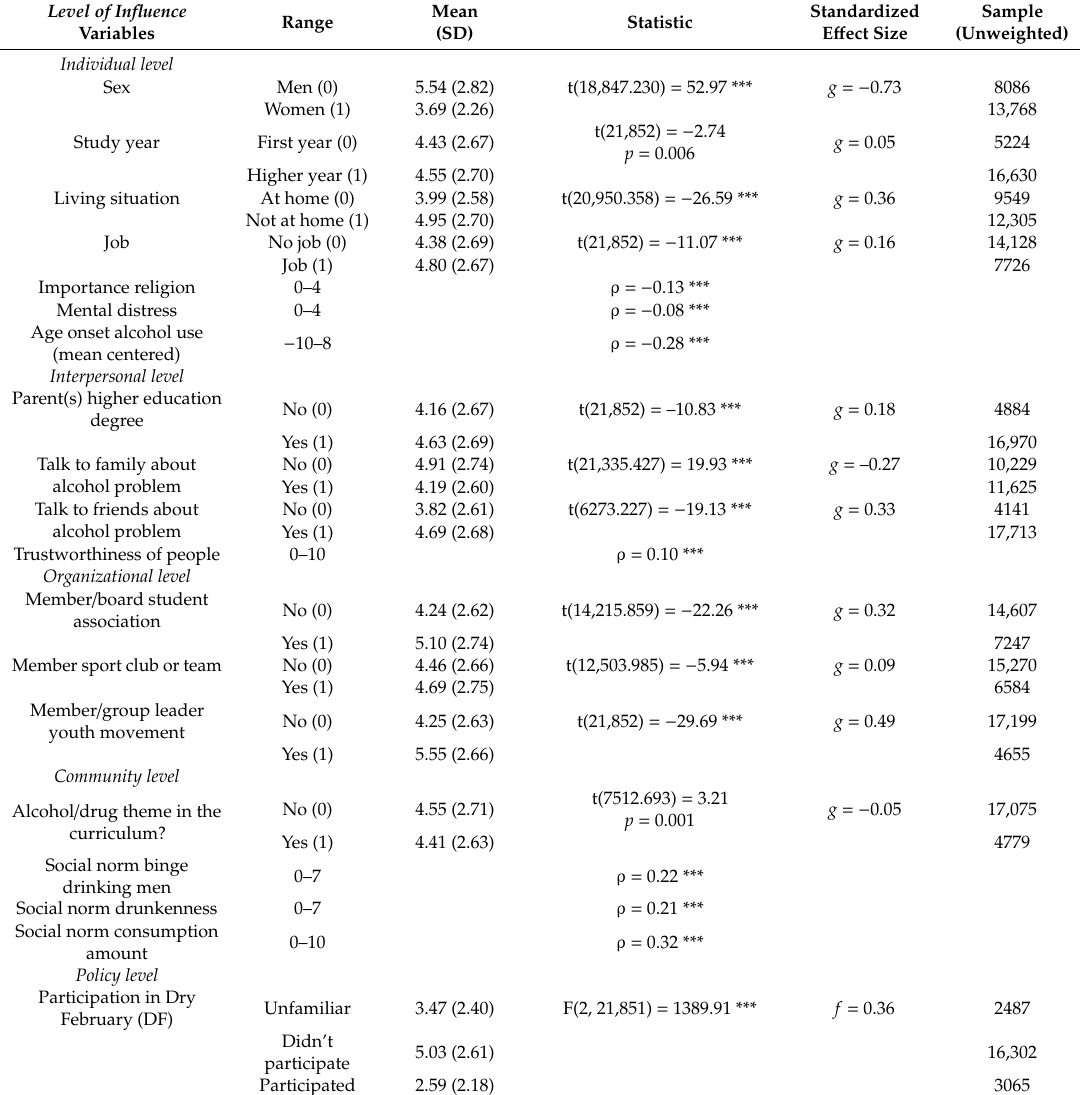
Table 2. Descriptive statistics with di ff erences in AUDIT-C scores ( N =